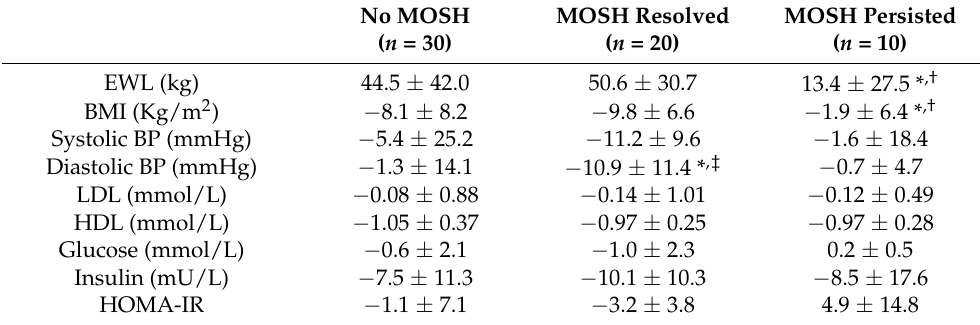
Table 2. Changes at follow-up depending on the presence of MOSH and its resolution.